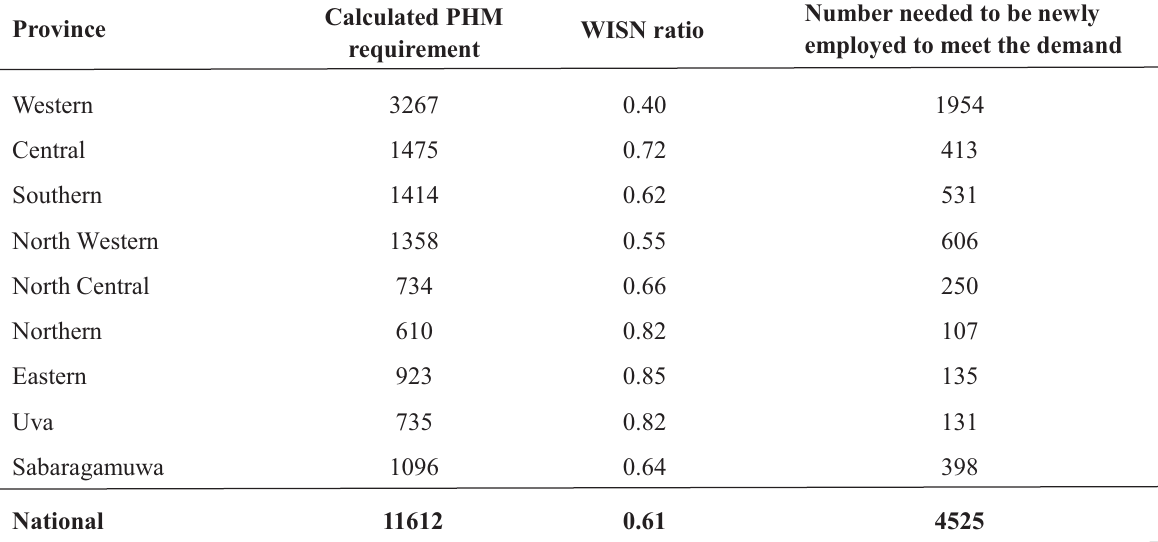
Table 1: Workload indicator staffing needs by provinces Province